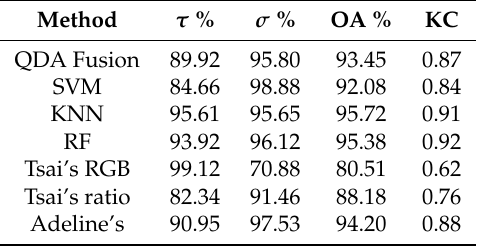
Figure 9. Results of property methods (1) Results for Tsai’s method on RGB features; (2) Results for Tsai’s method on the ratio feature; (3) Results for Adeline’s method on the intensity feature; ( a ) Results of three methods for two cases in Amersfoort shown in the green box from Figure 8. ( b ) Results of three methods for two cases in Toronto shown in the green box from Figure 10. Table 1. Comparative results for shadow detection in